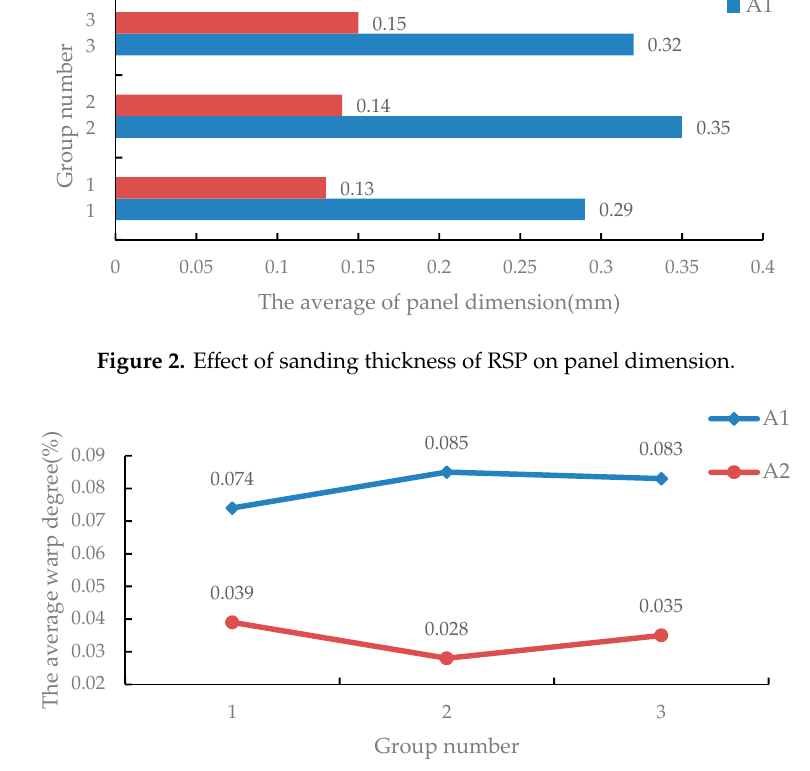
ff ect of sanding thickness of RSP on warp Figure 3. Effect of sanding thickness of RSP on warp degree. Figure 3. E Figure 3. Effect of sanding thickness of RSP on warp degree.